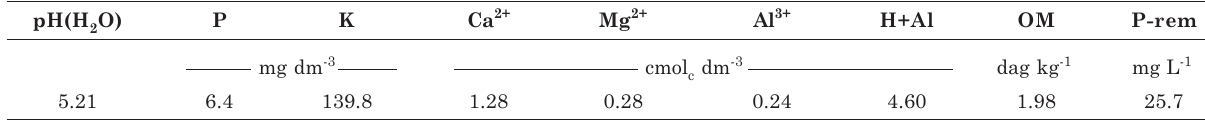
(1) Mean values obtained in the control treatment in 2008 and 2009. P and K: extractor Mehlich-1; Ca, Mg and Al exchangeable: extractor: 1 mol L -1 KCl; H+Al: extractor 0.5 mol L -1 calcium acetate, pH 7.0; Organic matter (OM): Walkley-Black method; P-rem: Alvarez V. et al.